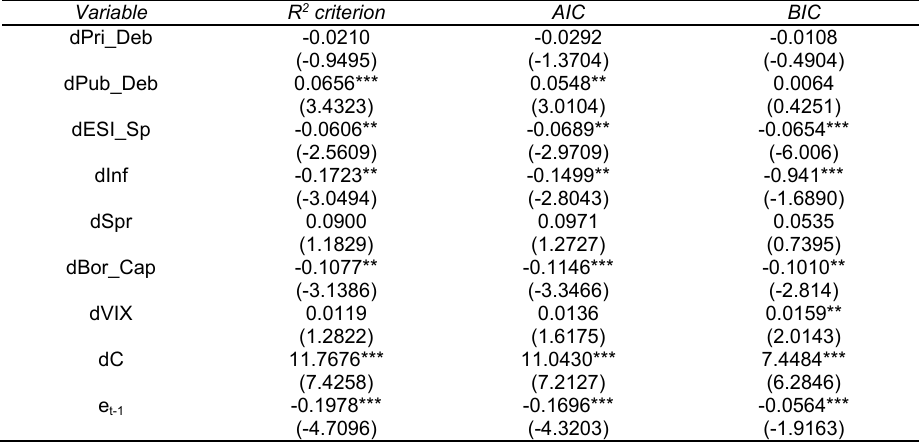
Table 7. ARDL coefficients in the short term model (ECM)